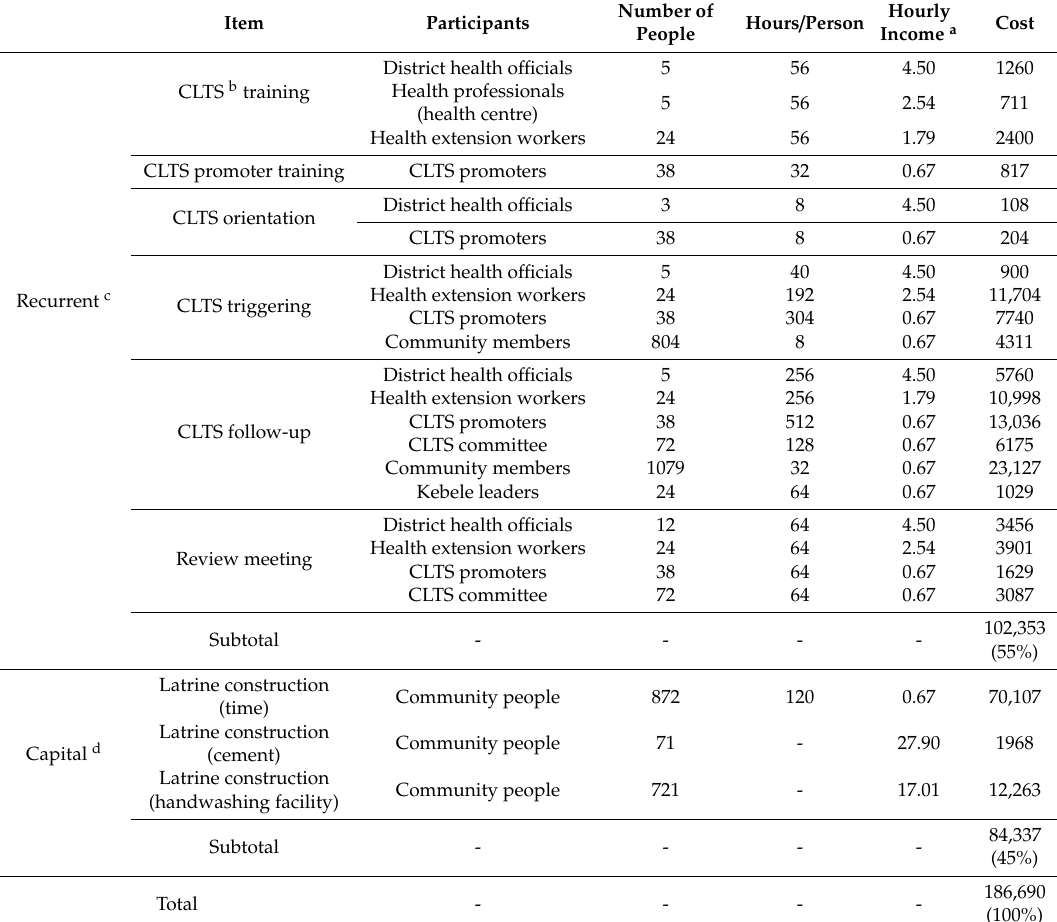
Table 5. Initial costs (community members’ and local stakeholders’ investments, Int’l $).